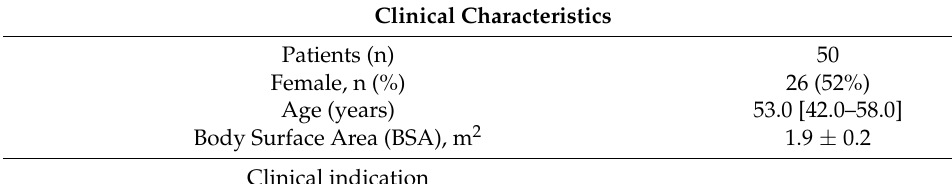
Table 1. Patient characteristics and cardiac magnetic resonance (CMR) findings.